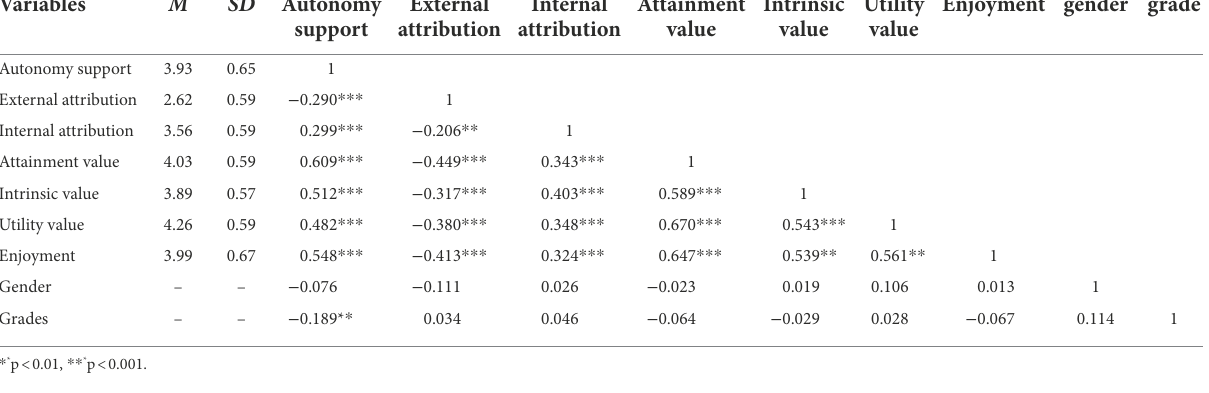
TABLE 1 Means, standard deviations, and correlations among the main variables.